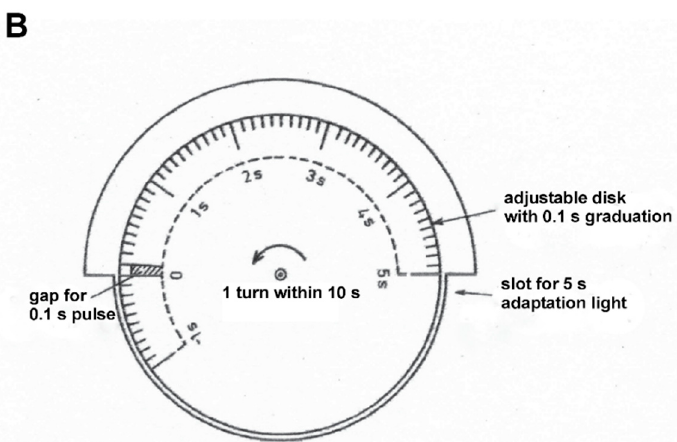
Figure 1. Equipment for generating adaptation and stimulation light. ( A ) The light source L 1 generates the adaptation pulse via the mirror M and the test stimulus directly. The respective strengths are set by neutral filters at NA, the field sizes of 10° and 5° by diaphragms. The light source L 2 generates the continuous adaptation light. Its intensity is adjusted by a neutral filter at NA and its field size (30°) by a diaphragm. The beam paths are combined at the semi-transparent mirrors SPM. L 1 and L 2 are 12 V, 50 W incandescent lamps; ( B ) Disc combination for the generation of adaptation pulse and stimulus light. The disc makes one revolution in 10 s, thereby clearing the beam path for the adaptation pulse for 5 s, and that for the stimulus light for 0.1 s. The disc consists of 2 single discs. Their twisting against each other makes it possible to change the time interval between adaptation step and stimulus light from − 1.0 s (stimulus light 1 s before adaptation step) up to +5.0 s (stimulus light 5 s after adaptation step).